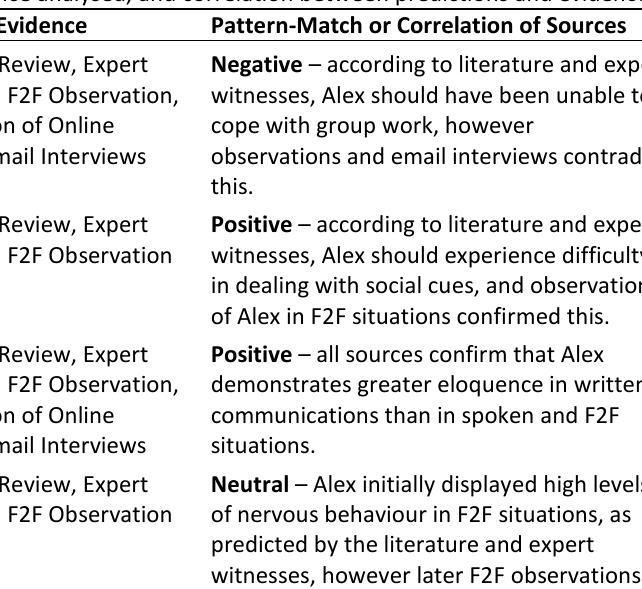
Table 1 . Illustrating the predictions, sources of evidence analysed, and correlation between predictions and